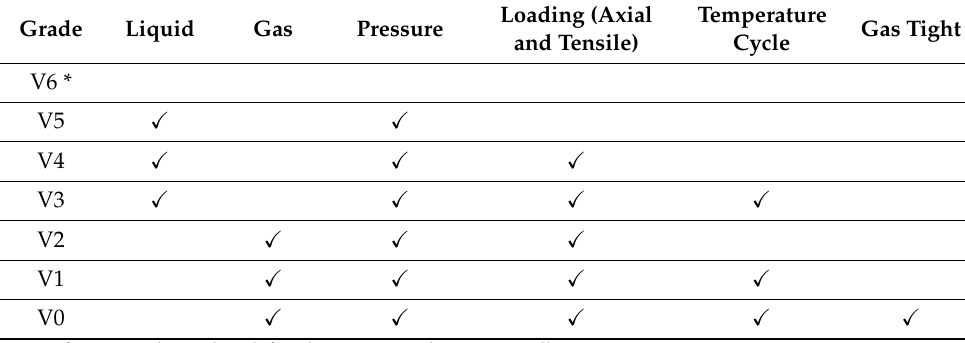
Table 5. Summary of packer grades tests according to API Specification 11D1 and